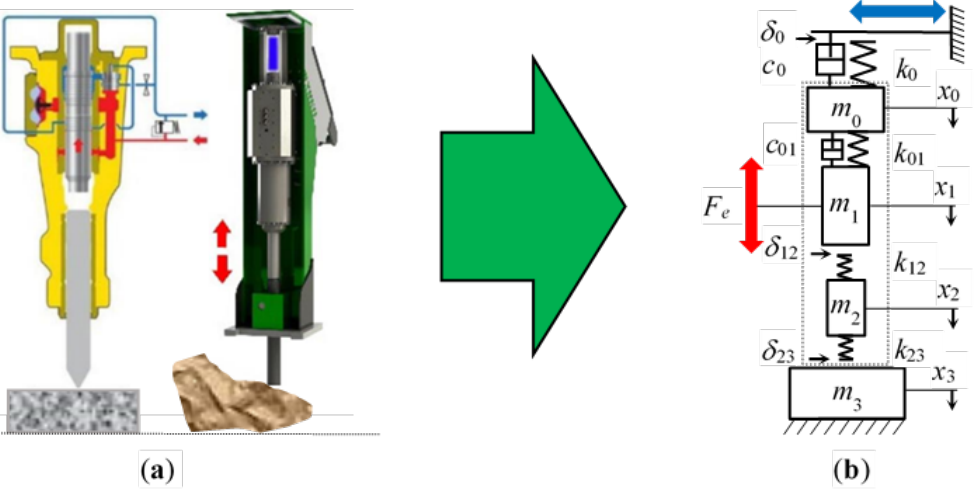
Figure 7. Hydraulic and electric hammers with different available shapes of chisels for rock-piece crushing ( a ); and the generalized multi-body dynamical model (own study) ( b